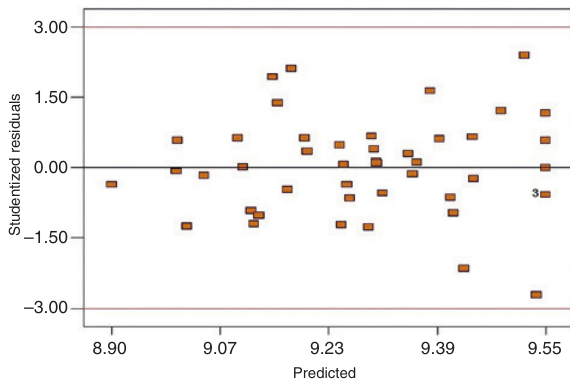
Figure 8: Residual vs.